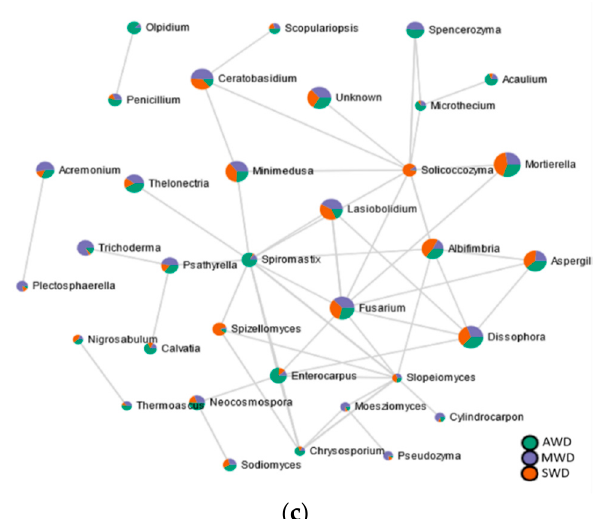
Figure 9. SparCC correlation analysis at genus level among irrigation regimes (SWD: severe water deficit, MWD: moderate water deficit, and AWD: absence of water deficit) in the ( a ) root, ( b ) rhizo- sphere, and ( c ) bulk soil.